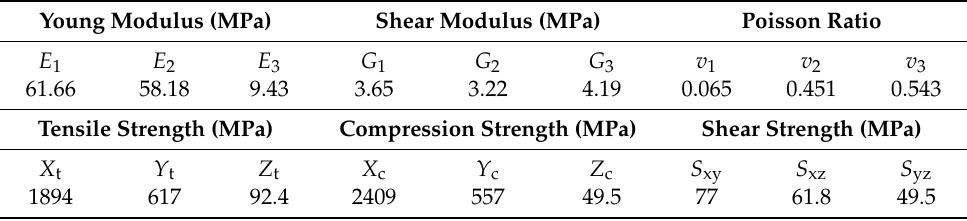
Table 1. Performance parameters of carbon fiber epoxy resin composites.